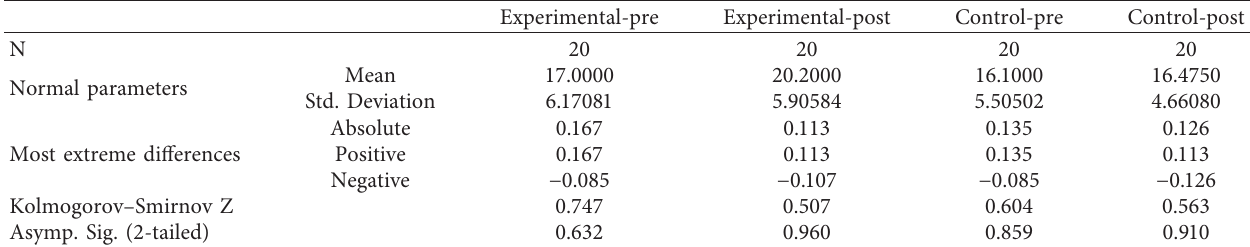
Table 1: Results of the one-sample Kolmogorov–Smirnov test.